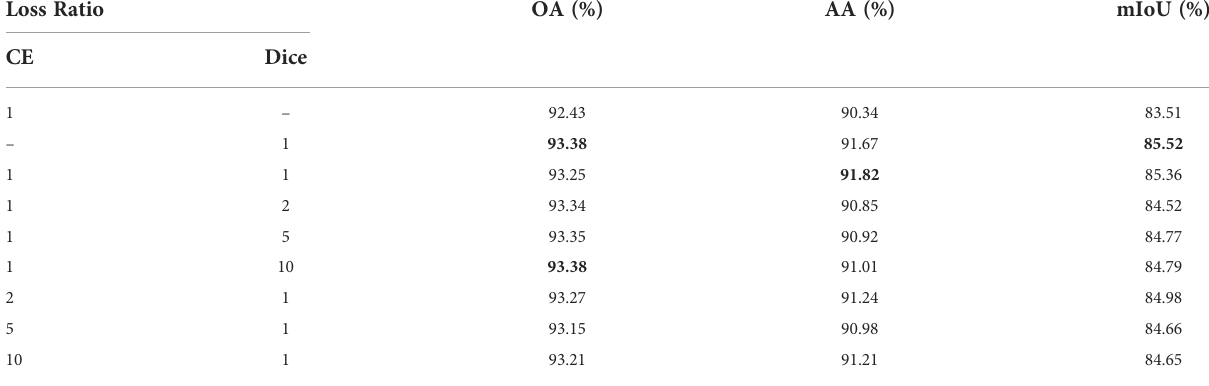
TABLE 2 Loss function